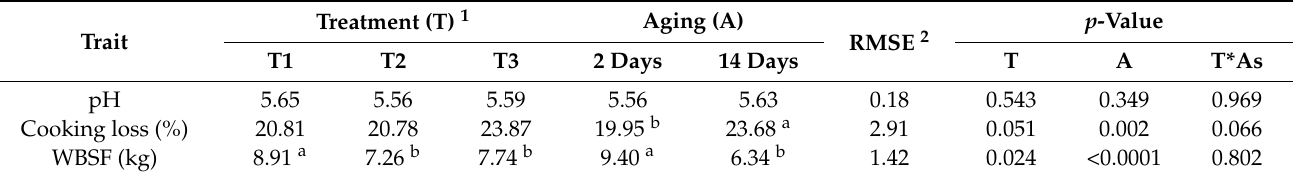
Table 2. Effect of dietary-energy-density treatment (T) 1 and aging time (A) on pH, cooking loss,